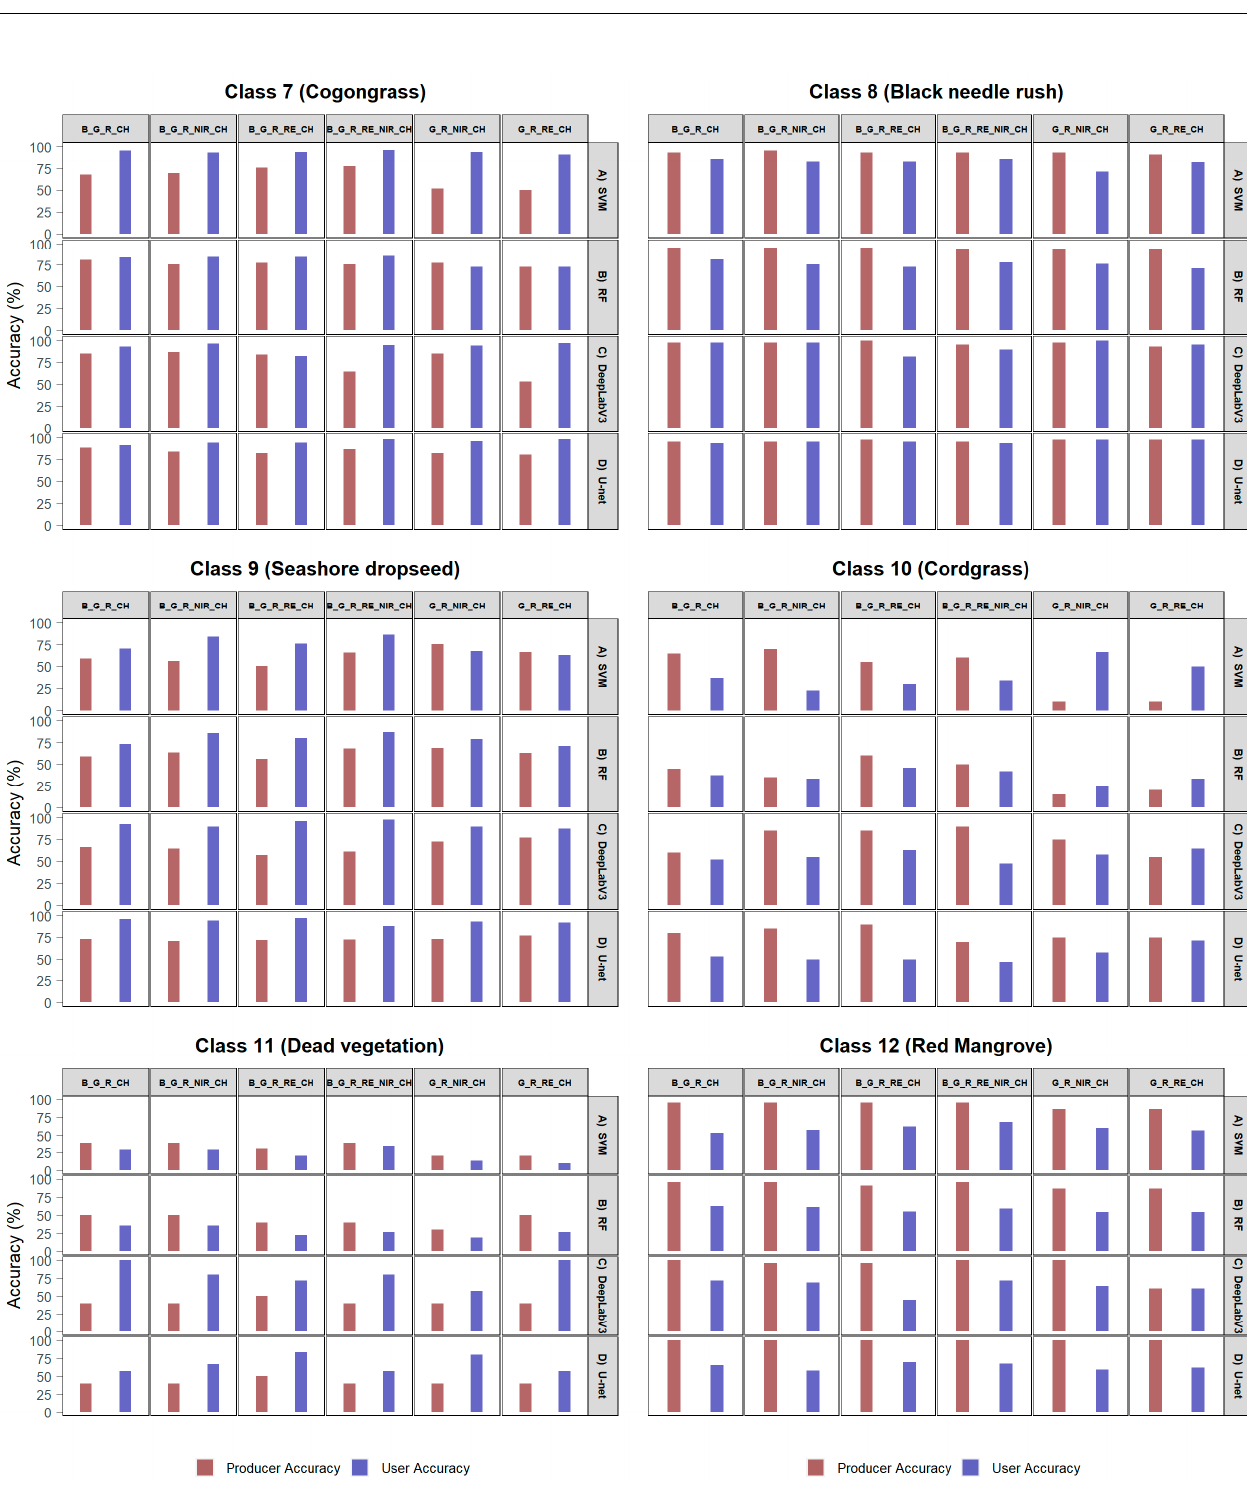
Figure A8. Experiment: EXP3-SB_ UAS_CHM, producer and user accuracy organized by class and classification method., classes 7 to 12.